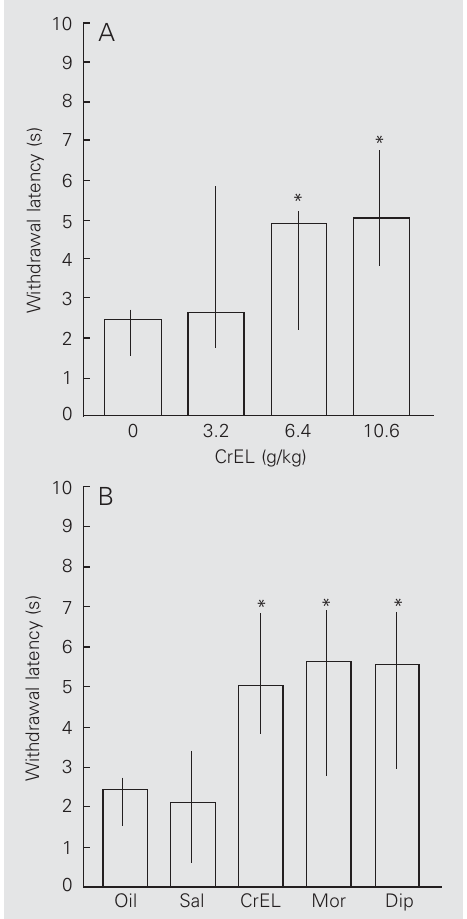
Figure 2. Effect of Cremophor EL (CrEL) (A) and comparison between the effects of CrEL (10.6 g/kg), morphine (20 mg/kg) and dipyrone (300 mg/kg) (B) on the latency to withdraw the tail in the tail immersion test in mice. *P<0.05 compared with the Oil group (A) or Oil and Sal groups (B) (Mann-Whitney U-test). Data are reported as the median ± in- terquartile range for 6-7 animals in each group. Oil: castor oil,